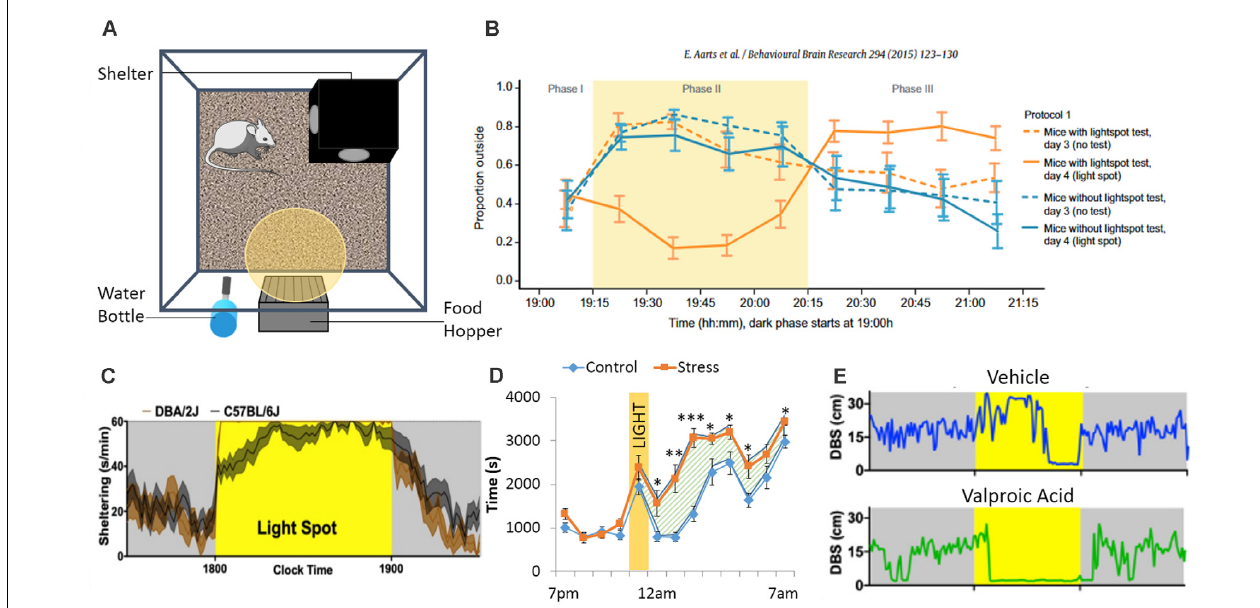
FIGURE 4 | The PhenoTyper boxes are equipped with a shelter, a food hopper, a water bottle, a yellow (or white) LED light and a ceiling mounted camera allowing tracking of the animals (A) . During the dark phase, the LED light can be turned ON, shining above the food zone. This creates a conflict between food intake and the subject’s fear of lit environment. In the Light Spot Test (B) , animals show reduced time spend outside of the shelter when the light is ON. A study from Jankovic et al (2019) identified strains differences regarding sheltering time in response to the light test, while other “standard” tests failed to identify strain differences (C) . Another way to assess anxiety-like behavior using the PhenoTyper would be to investigate how animals react to the light (as in the Light Spot Test) as well as their behavior when the light is turned back OFF. Residual avoidance behavior can be observed (D) in some cases, like after chronic stress exposure, where mice tend to stay in the shelter even when the light has been turned off, suggesting the presence of more pervasive anxiety-like behavior (the hatched area highlights the residual avoidance period ∗ p < 0.05; ∗∗ p < 0.01; ∗∗∗ p < 0.001). Finally, the Light Spot test can be performed with pairs of mice tested in the same PhenoTyper (without the shelter to ease tracking). During the light challenge, animals receiving valproic acid prenatally spent more time close to each other (DBS: distance between subjects), compared to animals receiving vehicle (E) . Figures are redrawn from Aarts et al. (2015), Bass et al. (2020), Jankovic et al. (2019), and Prevot et al.